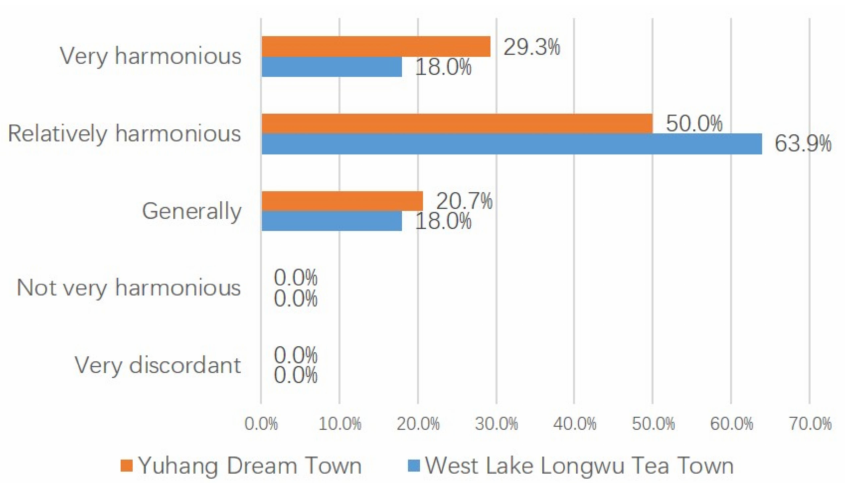
Figure 27. Changes in the interpersonal relationship between respondents and their neighbors after the local CT practice (source: